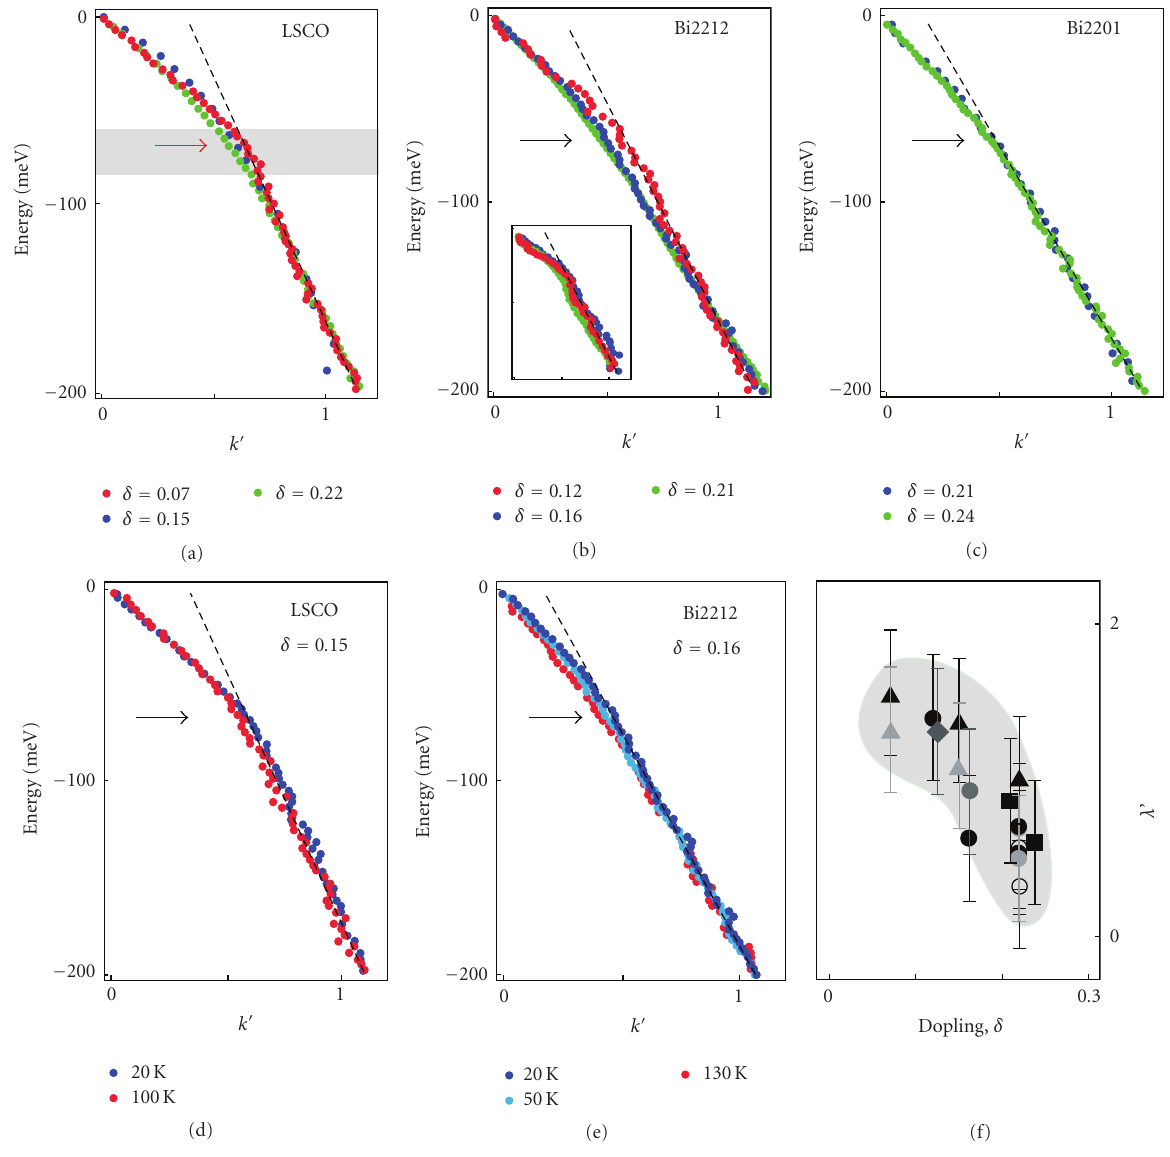
Figure 2: (a–e) ARPES data at the nodal point showing the ubiquity of the ARPES dispersion kink as determined from MDC fittings over a variety of cuprates systems, dopings, and temperatures above and below T c . The kink energy is indicated by the thick arrow and the momentum is rescaled so that k (cid:6) is 1 at 170 meV binding energy. (f) Estimating the electron coupling constant λ for the di ff erent samples as a function of their doping. Filled triangles, diamonds, squares, and circles are LSCO, Nd-LSCO, Bi2201, and Bi2212 in the first BZ, respectively. Open circles are Bi2212 in the second zone. Di ff erent shadings represent data from di ff erent experiments. The figures are from